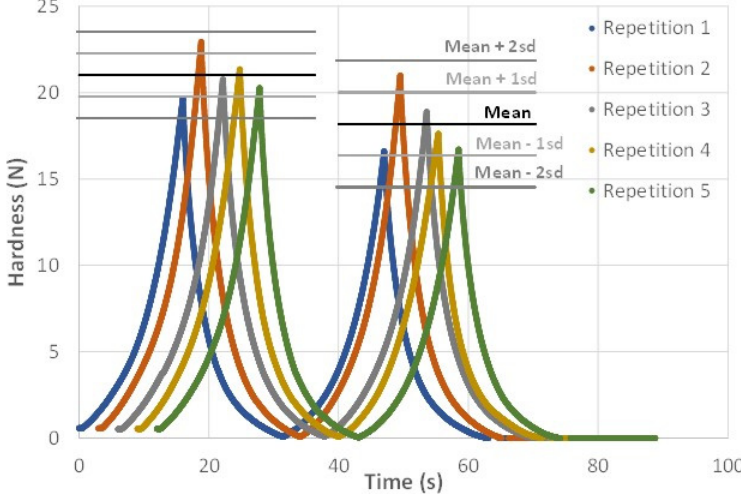
Figure 9. Hardness measurements of printed protein gels using the TPA test. The horizontal line represents the mean (in black) of the maximum forces for the five samples, and for the two successive compressions. The standard deviations around this mean are represented by the shaded